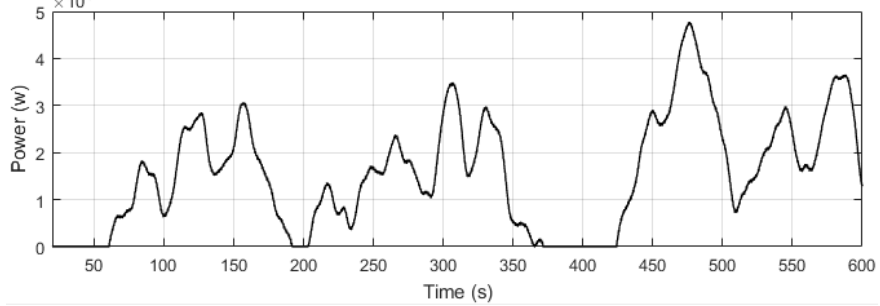
Figure 13. The insufficient power reference to the gas turbine .